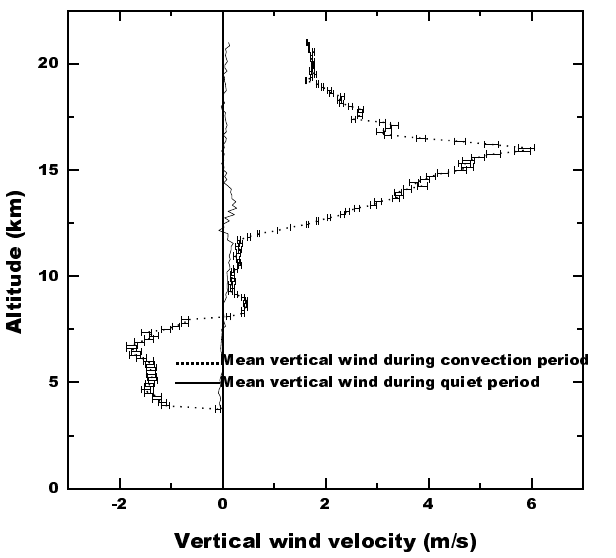
Fig. 4. Convection event on 28 August 1999: vertical profiles of mean value of vertical wind during both convection (dotted with error bars) and non-convection periods (full line).